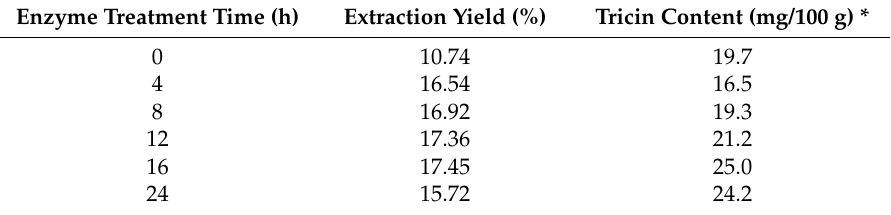
Table 1. Tricin contents of Zizania latifolia (ETZL) depend on enzyme treatment time. Enzyme Treatment Time (h)